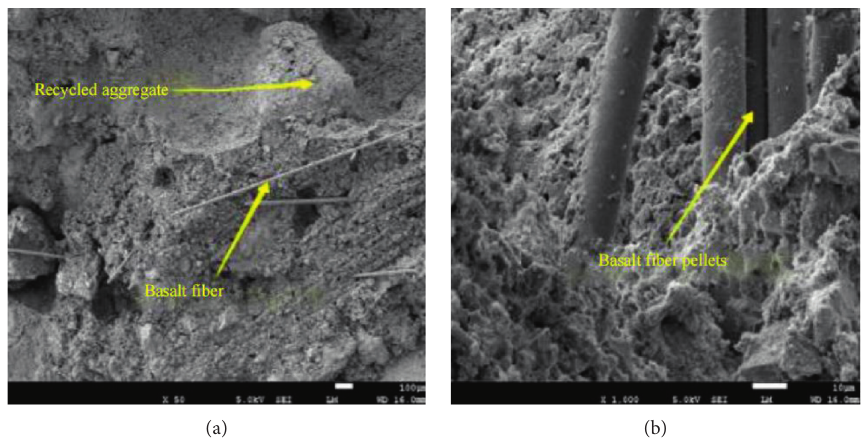
Figure 21: Cement-stabilized recycled aggregate base with fiber.